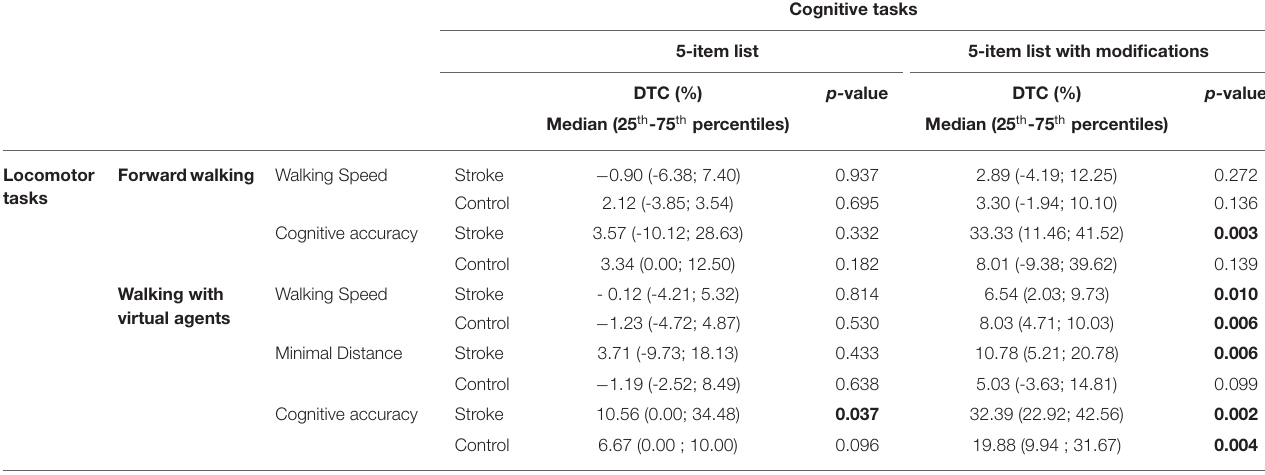
TABLE 2 | Locomotor and cognitive DTCs in each DT condition for each